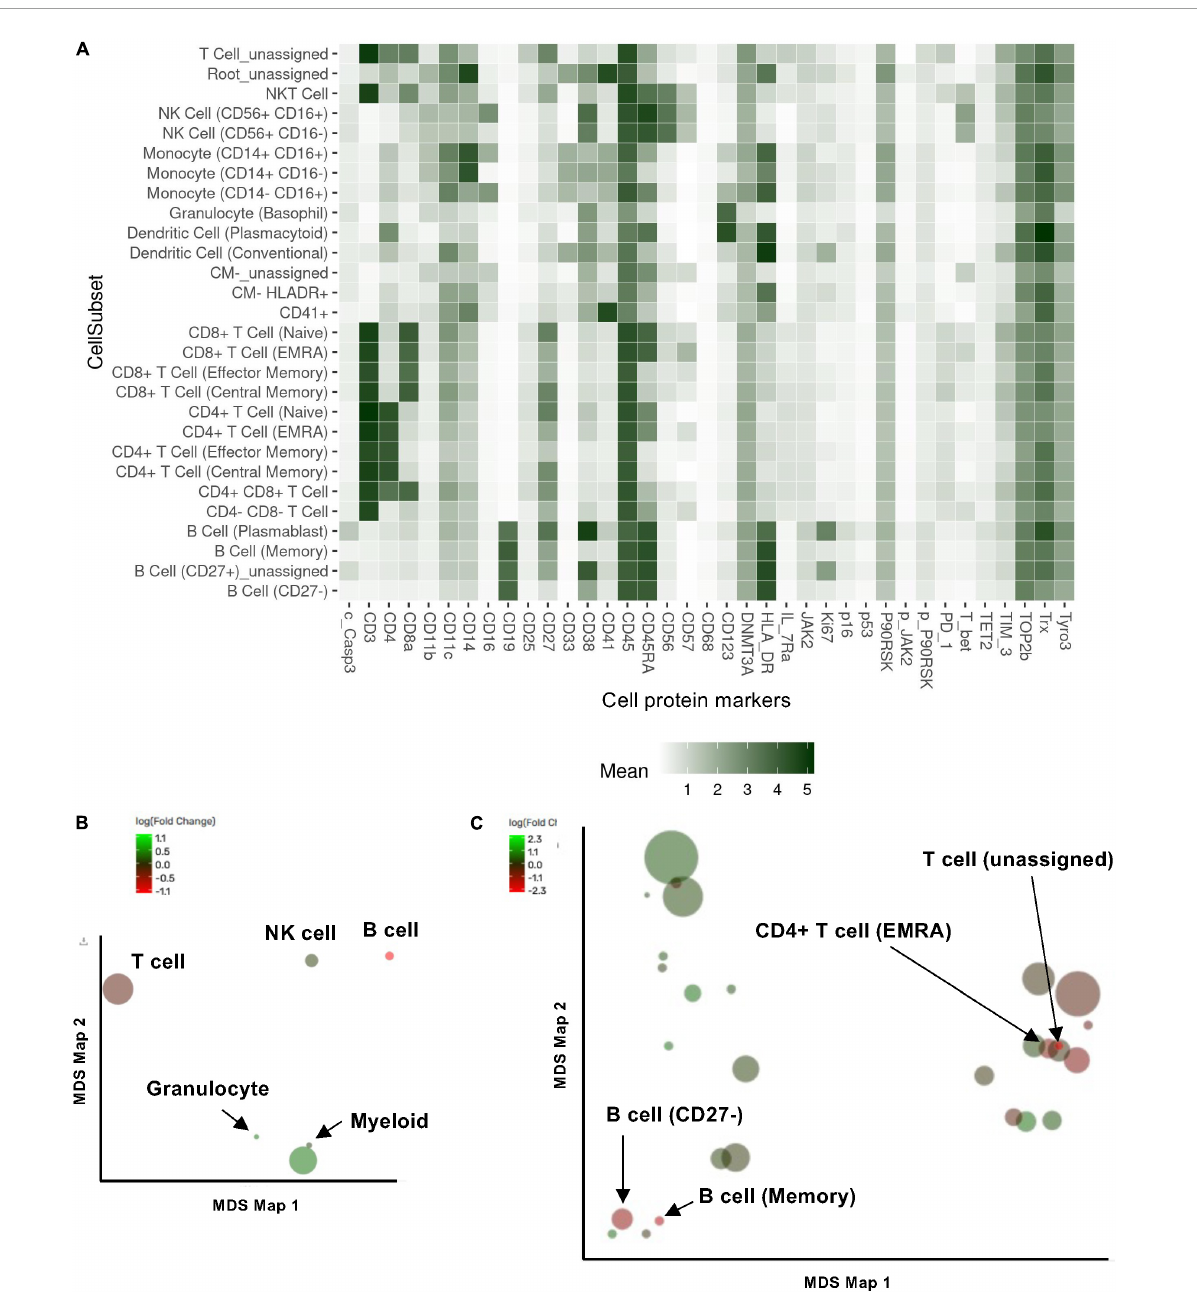
FIGURE1 Cell subset using the Astrolabe platform. The FlowSOM algorithm clustered cells and labeled subsets according to the canonical gating hierarchy. (A) Cell subset heat map. The rows represent cell subsets, and the columns represent cell protein expression. Tile intensity showed the median value in the subset according to the color key. (B,C) Multidimensional scaling (MDS) map for each cell type (B) and cell subsets clustered by Astrolabe platform as shown in (A) . Each bubble represents a cell type (B) or subset (C) , and the size of that bubble is determined by the median frequency of cells contained in that bubble across all samples analyzed. Each bubble is colored based on the magnitude of the fold change post-radiation therapy (RT) over